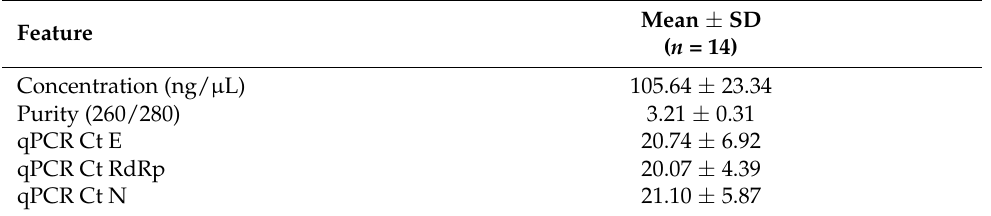
Table 2. Main features of the SARS-CoV-2 positive RNA samples employed in the cDNA synthesis.